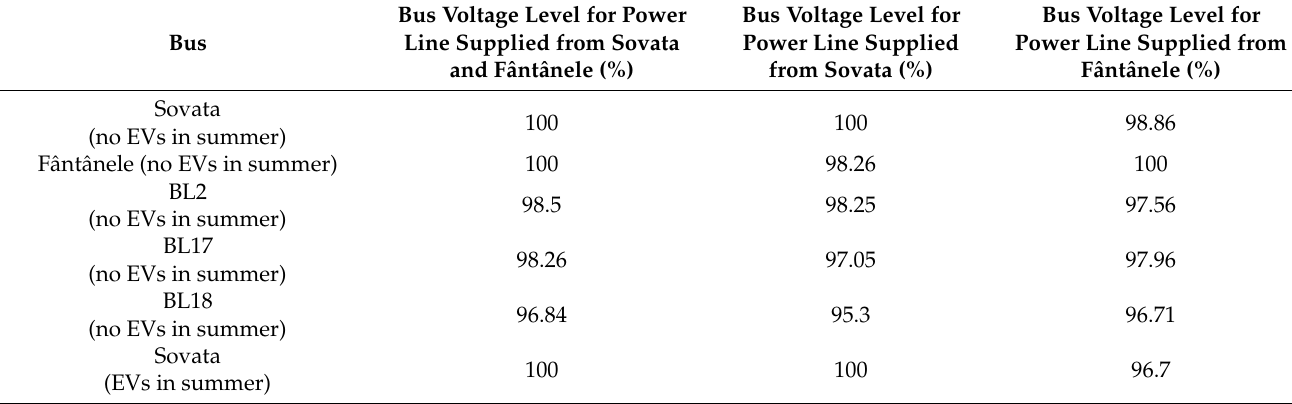
Table 22. Voltage level at 12:00 (scenario